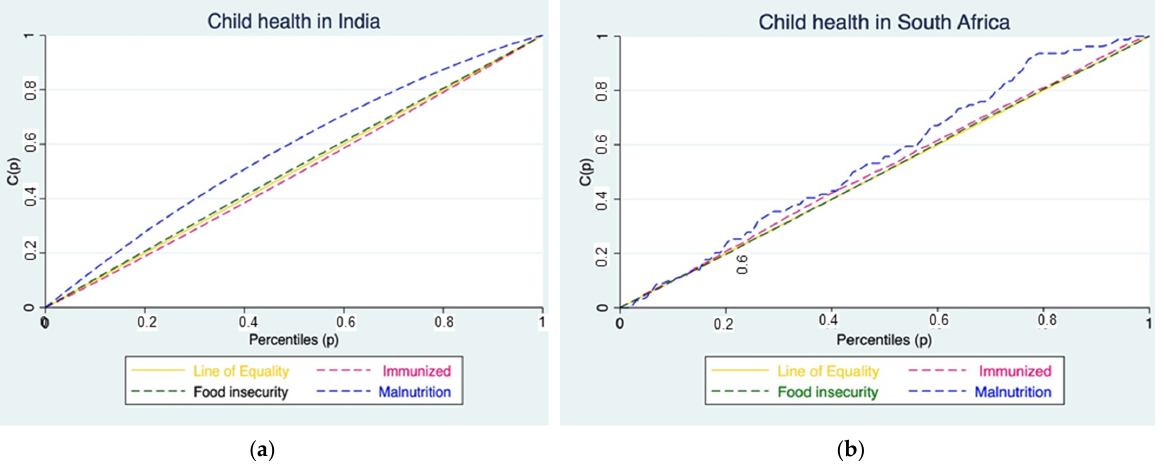
Table 4. Test of dominance between child health indicators concentration curves and 45-degree line (line of equality) for South Africa.